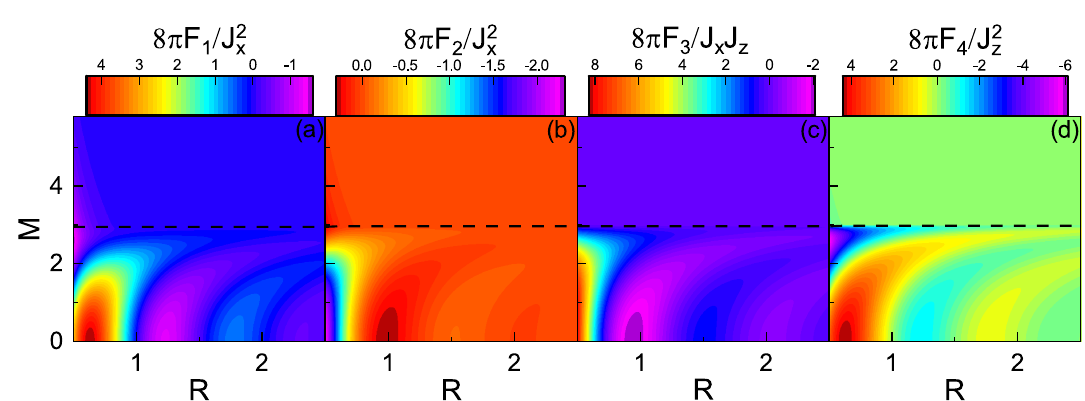
Figure 3. (Color online) (a) F 1 , (b) F 2 , (c) F 3 , and (d) F 4 as functions of R and E f with M Γ = 0 . The horizontal dashed line indicates E z